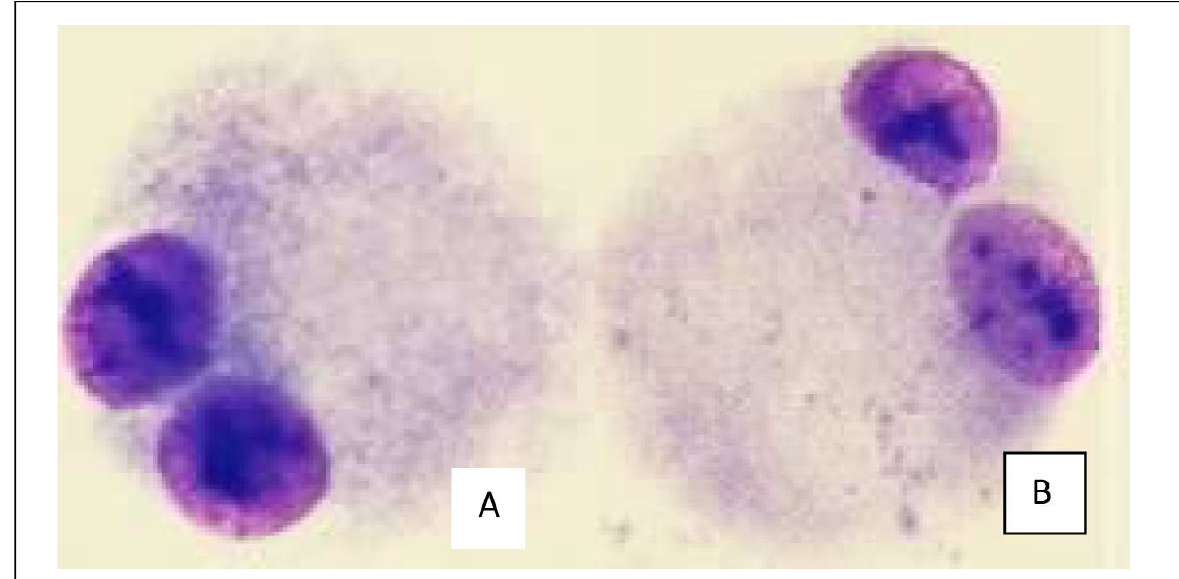
Pate 2: Control male (a) and female (b) showing bi nucleated cells with no micronuclei